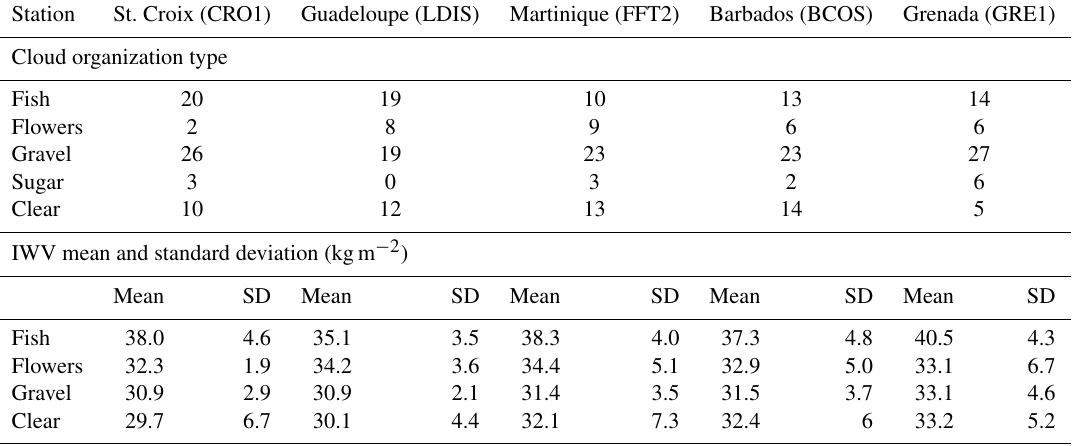
Table 6. Upper part: number of cases over the five sites of interest in the Caribbean arc in January and February 2020 for each cloud organization type (Fish, Flower, Gravel, Sugar, or lack thereof) according to the classification of (Stevens et al., 2020). The cases were identified by visual inspection of the MODIS Aqua and Terra visible images at 13:30 and 10:30 local Equator crossing time available from NASA WorldView (https://worldview.earthdata.nasa.gov/, last access: 29 January 2021). Lower part: mean and standard deviation of GNSS-derived IWVs associated with Fish, Gravel, Flowers, and clear conditions.